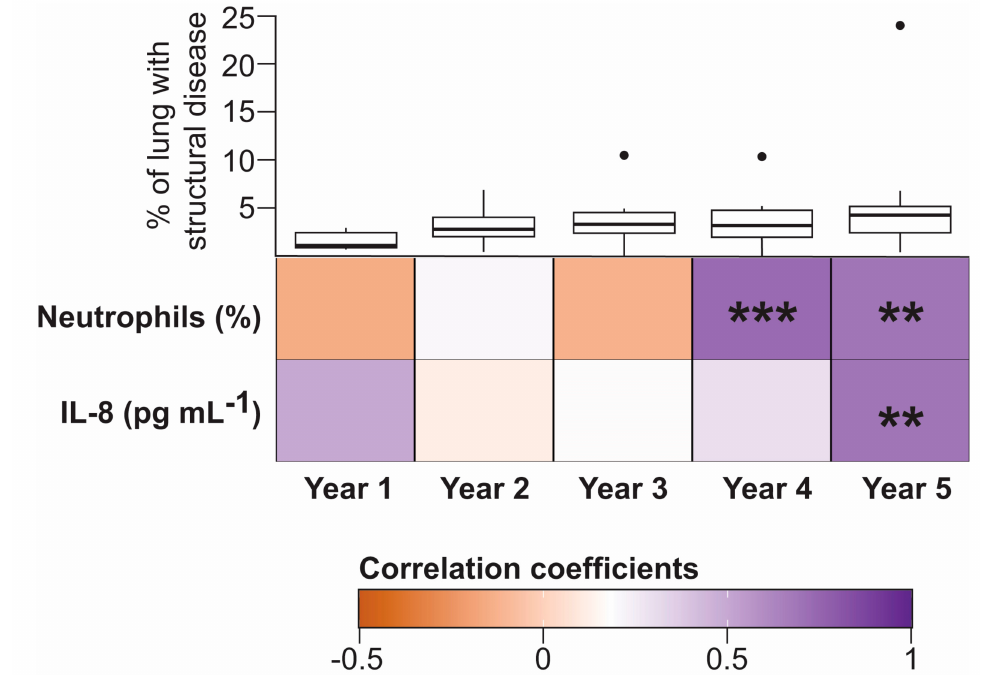
Figure 1. Temporal associations between bile acids (BAs) and inflammatory markers in bronchoalveolar lavage fluid (BALF). The heatmap represents the Spearman rank-order correlation coe ffi cients between total BA concentration (log10 transformed) and the indicated inflammatory biomarkers in BALF. Temporal co-occurrence is represented in samples obtained from one- to five-year-old cystic fibrosis (CF) subjects (Number of independent samples: year 1, n = 13; year 2, n = 14; year 3, n = 13; year 4, n = 16; year 5, n = 13). Boxplots in the top row represent the percentage of structural lung disease over the five-year period quantified using the PRAGMA protocol [36]. No significant di ff erences in airway remodelling were observed in the context of Dunnett’s test between year 1 and each of the following four years. Asterisks indicate statistical significance for the indicated correlation per year after false discovery rate (FDR) correction. **, p < 0.01; ***, p <